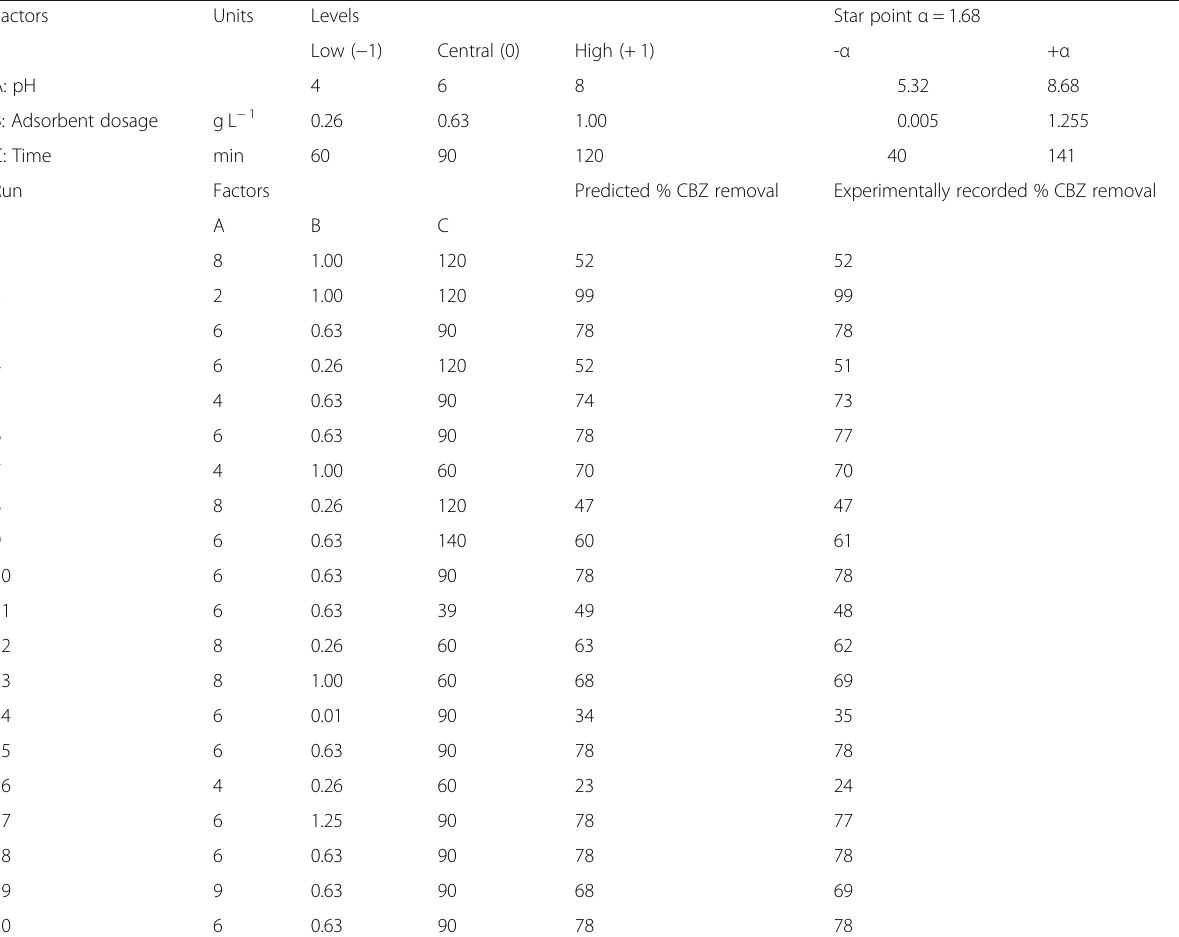
Table 1 Experimental details and results obtained for RSM (CCD) based optimization of Carbamazepine (CBZ) adsorption by graphene oxide (GO)